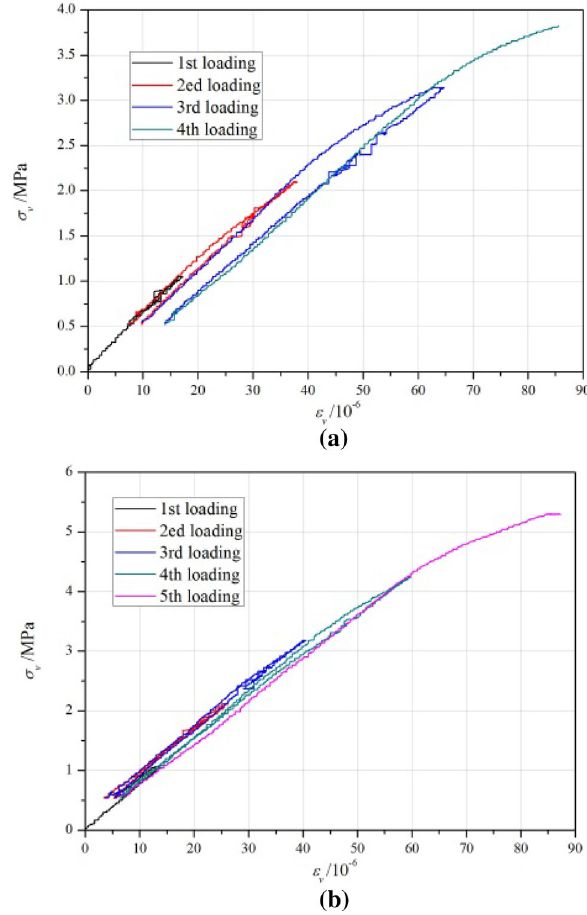
Fig. 6 Stress-strain curves in cycle tensile loading for the two groups of specimens. a A6 specimen, b B6 specimen